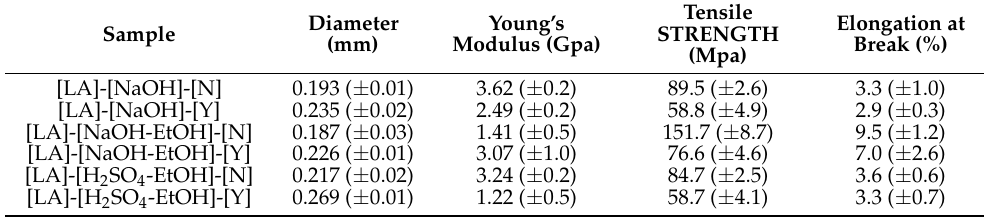
Table 4. Mechanical properties of wet spun monofilaments using lactic acid as the solvent.